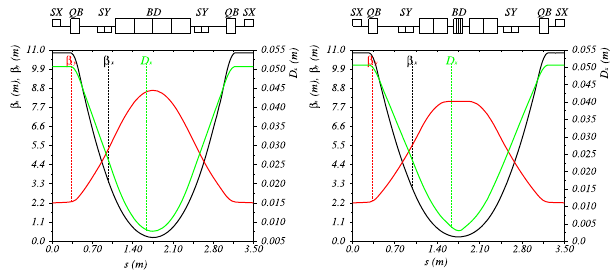
FIG. 13. Optical functions of SKIF base cell (left) and cell with high field dipole